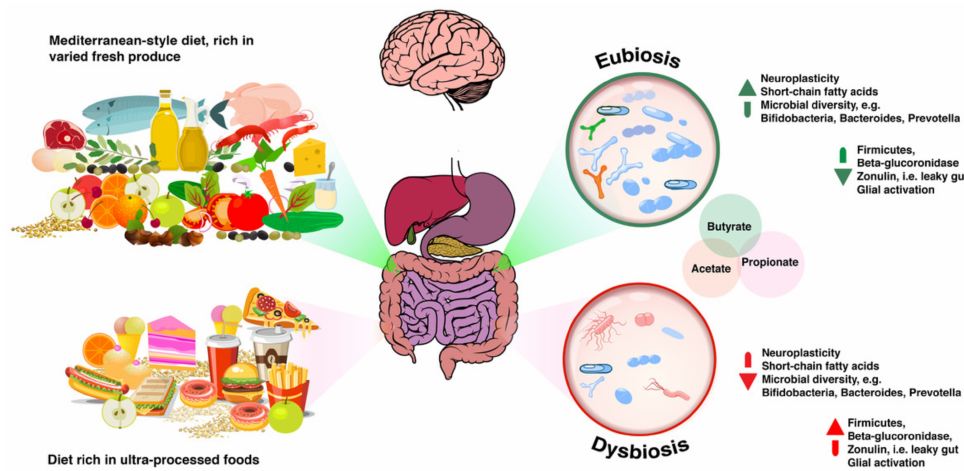
Figure 2. Dietary patterns that are rich in fresh produce, including a variety of brightly-coloured vegetables and fruits, olive oil, nuts and seeds, e.g., a Mediterranean-style diet, are seen to promote eubiosis, contributing to higher levels of all three short chain fatty acids and to a wider microbial diversity, with lower relative abundance in Firmicutes. Other characteristics of a eubiotic gut ecosystem include lower levels of beta-glucuronidase, documented to help with normal elimination of toxicants, and lower zonulin levels, seen as an indication of reduced susceptibility of damage to the intestinal barrier, i.e., less “leaky gut”. In this scenario, less glial activation is observed, resulting in decreased oxidative stress and increased neuroplasticity. On the other hand, dietary patterns rich in ultra-processed foods, and particularly those rich in refined carbohydrates combined with high fat levels are seen to promote gut dysbiosis. Lower microbial diversity, as well as lower levels of short chain fatty acid levels are seen in patients whose diets consist of mostly of ultra-processed foods, with higher relative abundance of Firmicutes. Other markers are also affected. Beta-glucuronidase may be higher, which could pose issues with toxicant elimination via reduced activity of phase II detoxification pathways. There is also a higher susceptibility for barrier tissue damage. Higher zonulin levels in stool would give practitioners an indication that this is the case. A disrupted intestinal barrier tends to be correlated with increased free radical damage to brain tissue, thereby increasing the chances